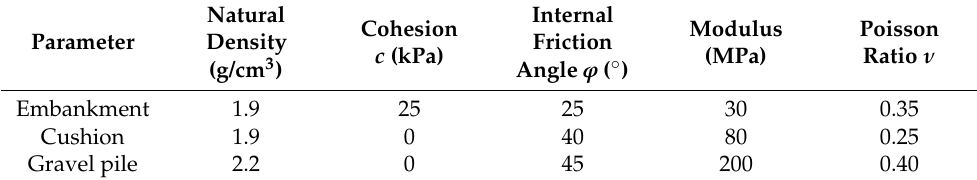
Table 2. Parameters of the foundation and gravel pile.